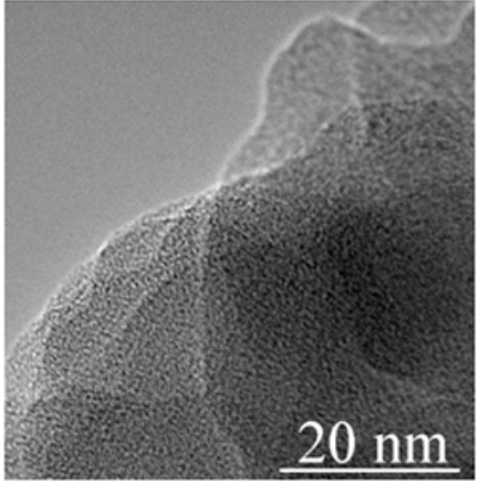
Figure 2. TEM image of the g -C 3 N 4 specimen before high-pressure treatment. The specimen resembles a set of amorphous flakes.